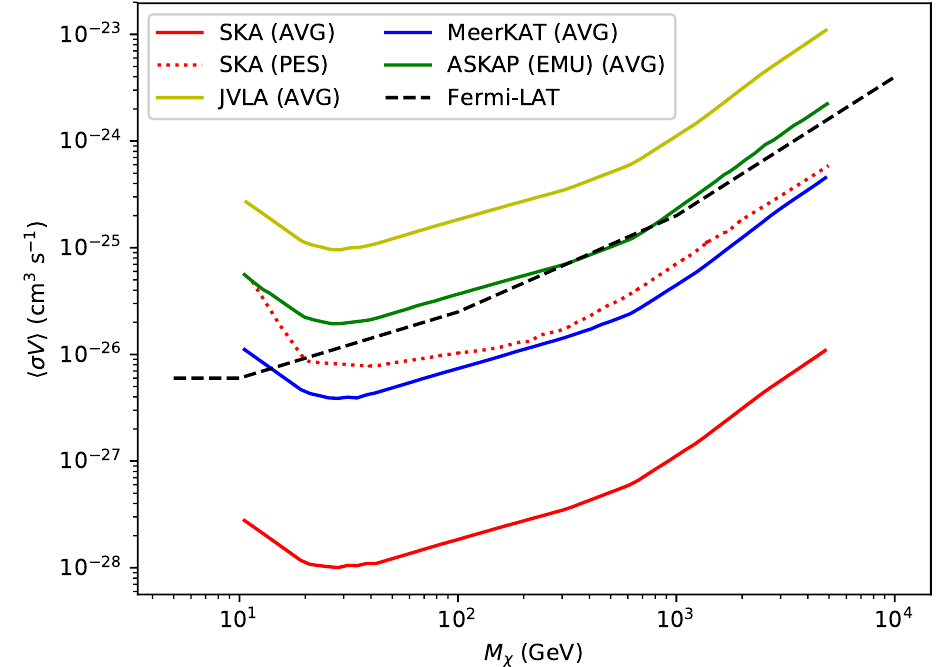
Figure 3. Cross-section upper limit prospects for the JVLA, ASKAP EMU, MeerKAT, and SKA from [29] compared to Fermi-LAT limits [6]. These limits are displayed at 95% confidence interval and only for the b -quark ( bb )